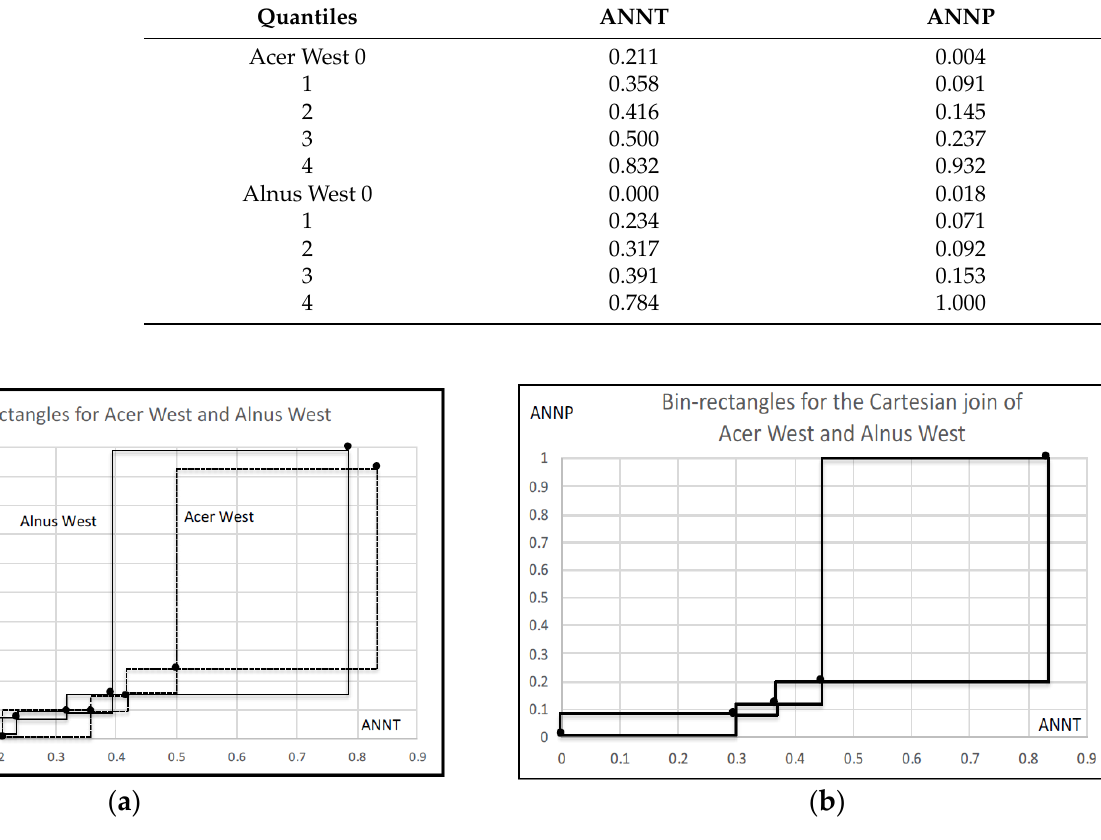
Figure 3. Bin-rectangles for two hardwoods and their Cartesian